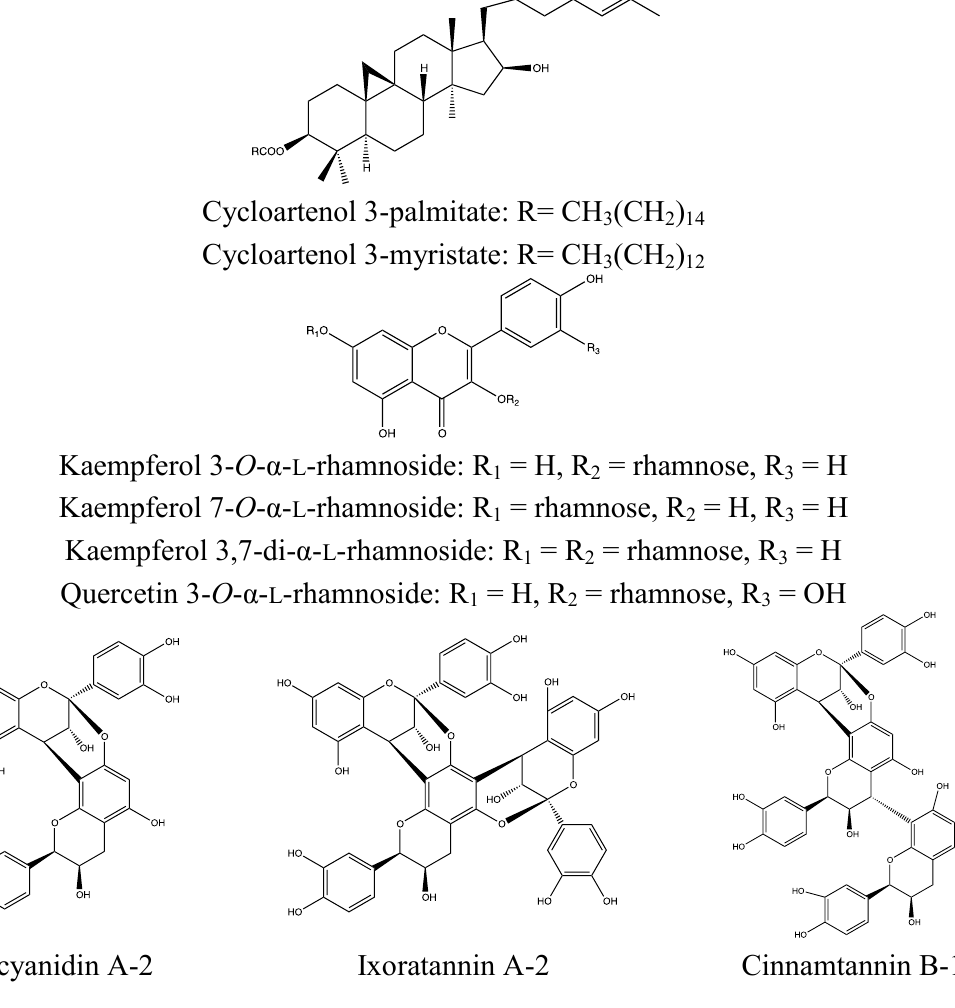
Cycloartenol 3-palmitate: R= CH Cycloartenol 3-myristate: R= CH